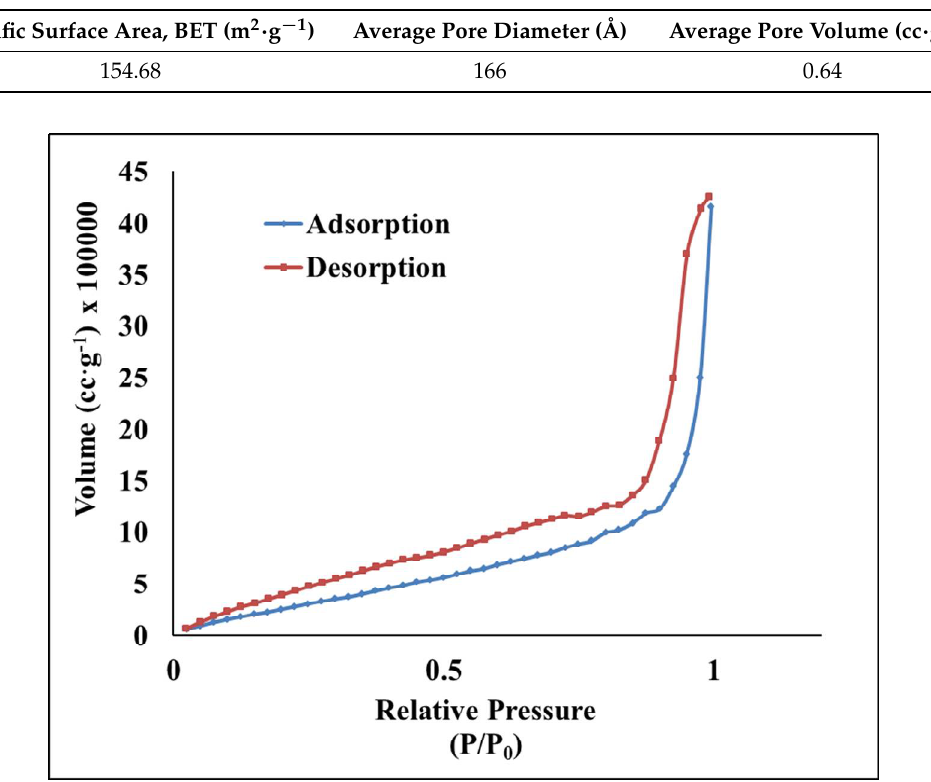
Figure 5. Nitrogen adsorption and desorption isotherms of the SWNH-monolith.